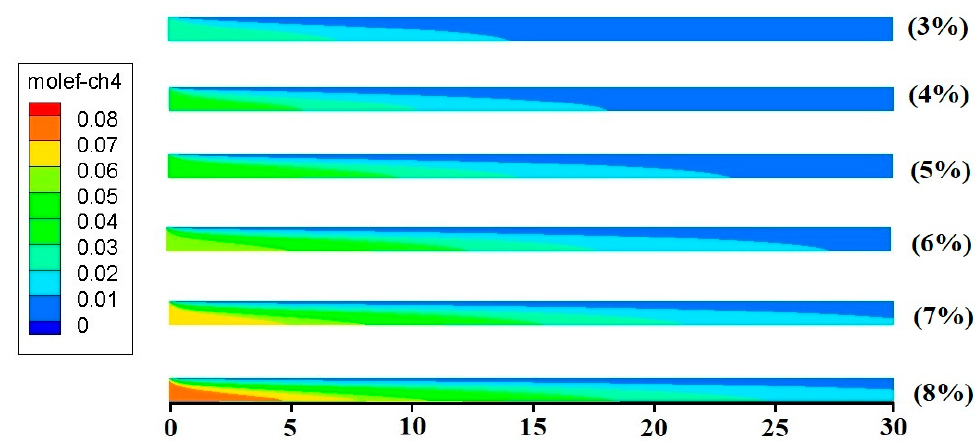
Figure 8. Distribution of methane concentration with different methane contents.